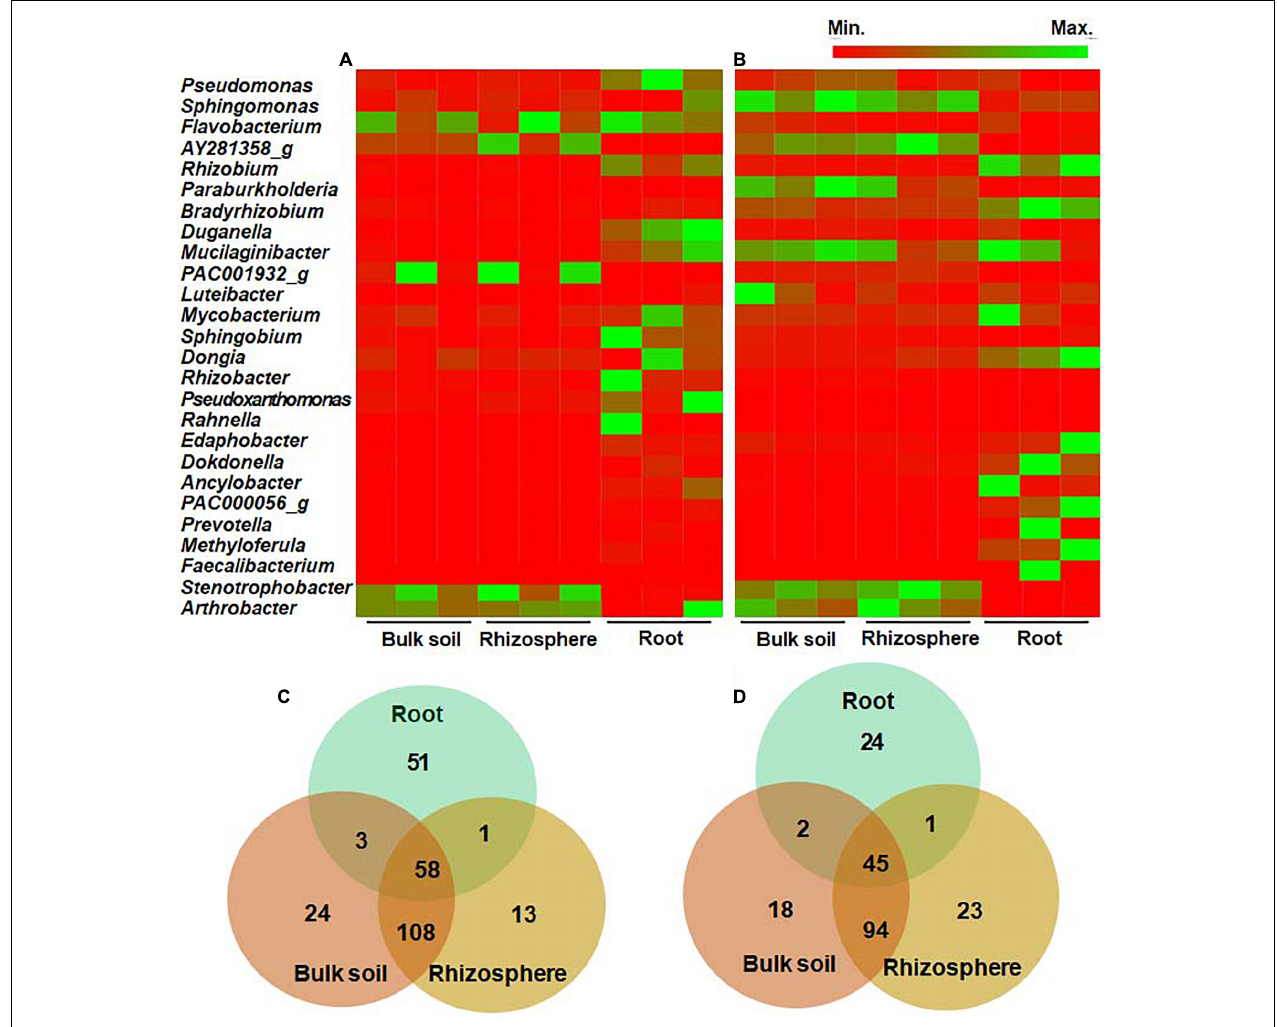
FIGURE 4 | Comparison of relative abundance of bacteria at the genus level in bulk soil, rhizosphere, and root of long-sepal Donggang pasque-flower plants. The heat map analysis compared bacterial genera showing more than 1% relative abundance in surrounding soils and roots of wild (A) and cultivated (B) habitats. The Venn diagrams show unique or shared genera of bacterial microbiota with relative abundance above 0.1% in each rhizocompartment of wild (C) and cultivated (D)